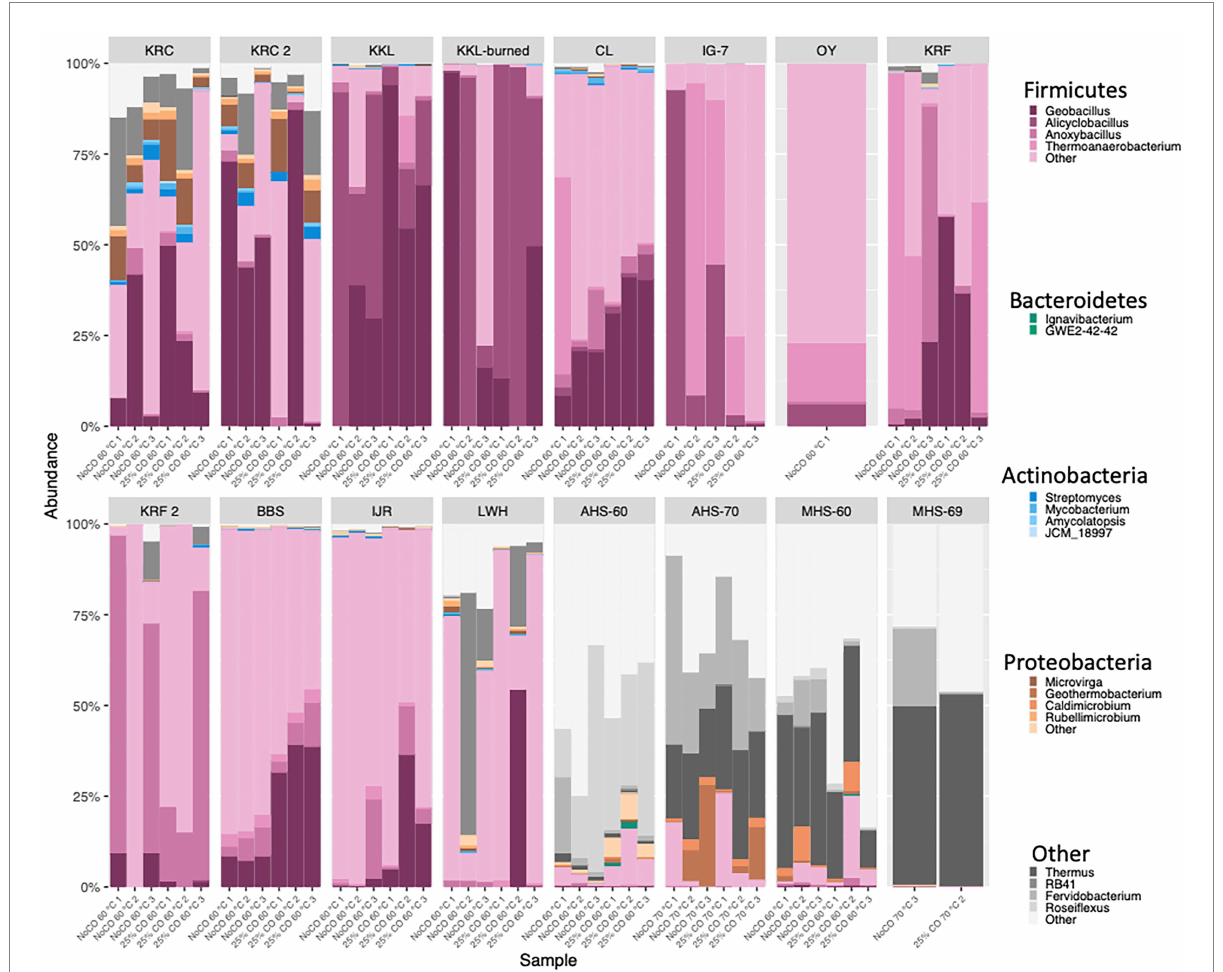
FIGURE 1 Taxonomic composition (phyla and genera indicated) for each of the sample replicates incubated under thermophilic conditions with or without 25% CO from which DNA was successfully extracted and amplified. KRC, Kueny Ranch Cultivated (1 = July, 2018; 2 = July, 2019); KKL, Kipukakulalio; KKL-burned, a stand of Acacia koa burned by a forest fire; CL, an 800-year old Miyake-jima forest; IG-7, vegetated 18-year old volcanic soils on O-yama Volcano (Miyake-jima); OY, sparsely vegetated 18-year old volcanic soils on O-yama Volcano; KRF, soil crust on an ~300-year old lava flow at Krafla Geothermal Field (1 = August, 2018; 2 = August, 2019); BBS, Bluebonnet Swamp, Louisiana; IJR, rice paddy, Ibaraki, Japan; LWH, Lake Waiau, Hawai’i; AHS, Alvord Hot Springs, Oregon (sample temperatures indicated by numbers), MHS, Mickey Hot Springs, Oregon (sample temperatures indicated by